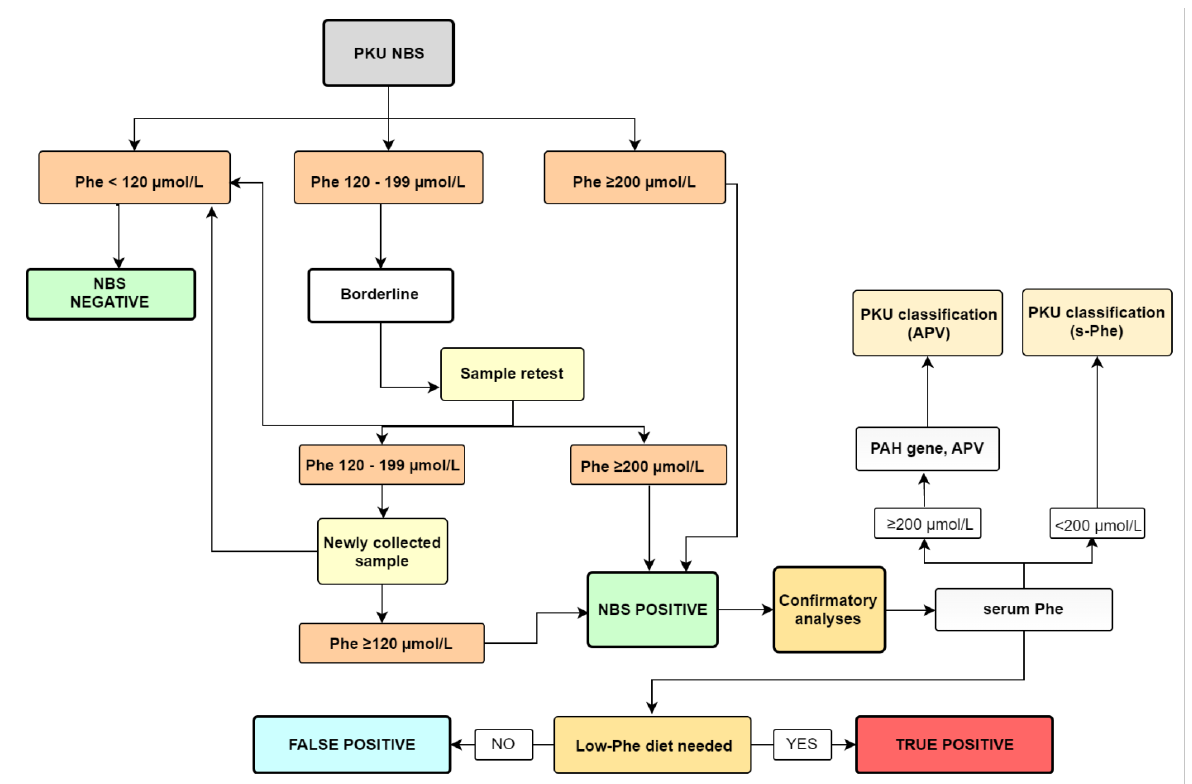
Figure 1. A diagnostic algorithm following abnormal newborn screening results for PKU.